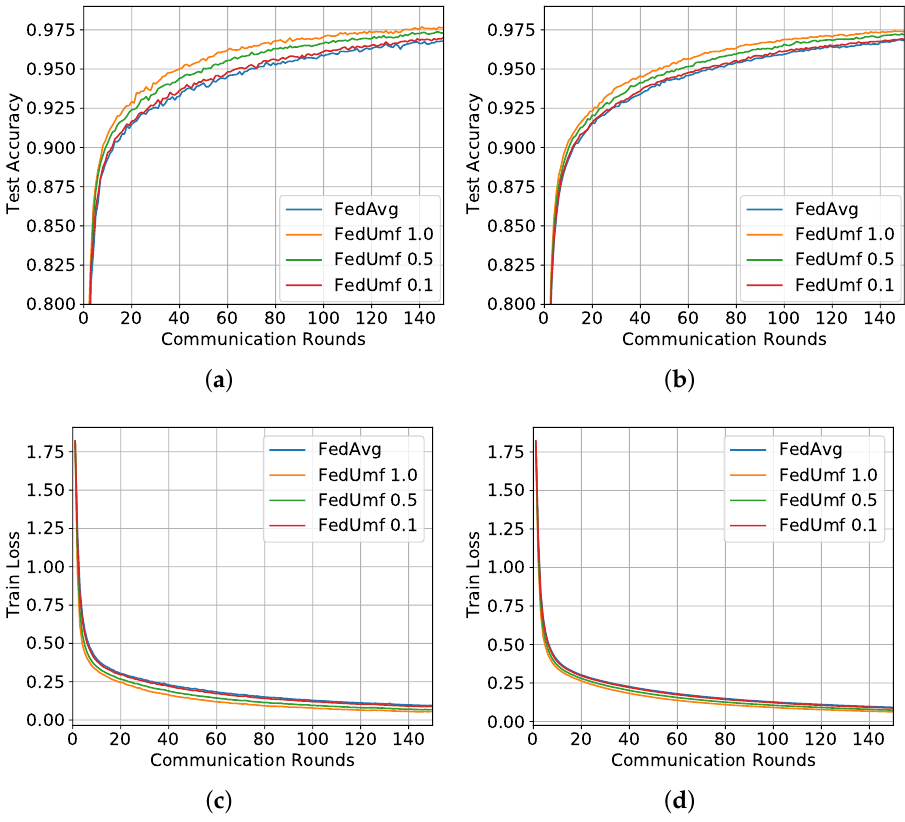
Figure 3. Server test accuracy and client-side training loss curve performance, IID partition and η = 0.01 on MNIST. ( a ) Test accuracy. C = 0.1. ( b ) Test accuracy. C = 0.5. ( c ) Training loss. C = 0.1. ( d ) Training loss. C = 0.5.